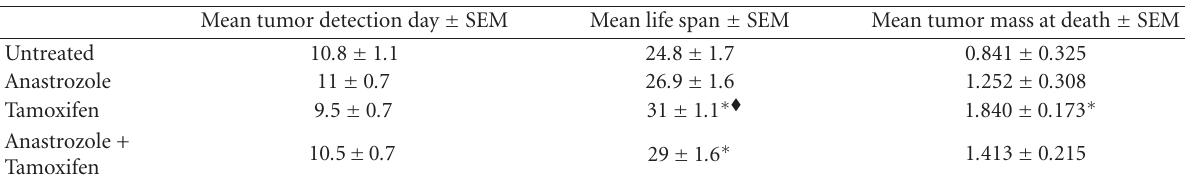
Table 1. Summarized results of the tumor development study. Female BALB/c mice were inoculated with 10000 4T1 cells subcu- taneously in the right hind thigh and treated with anastrozole, tamoxifen, the combination, or the untreated phosphate bu ff ered